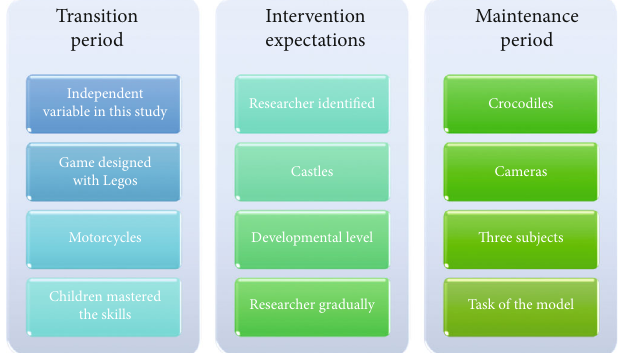
Figure 2: Flow chart of social sports game